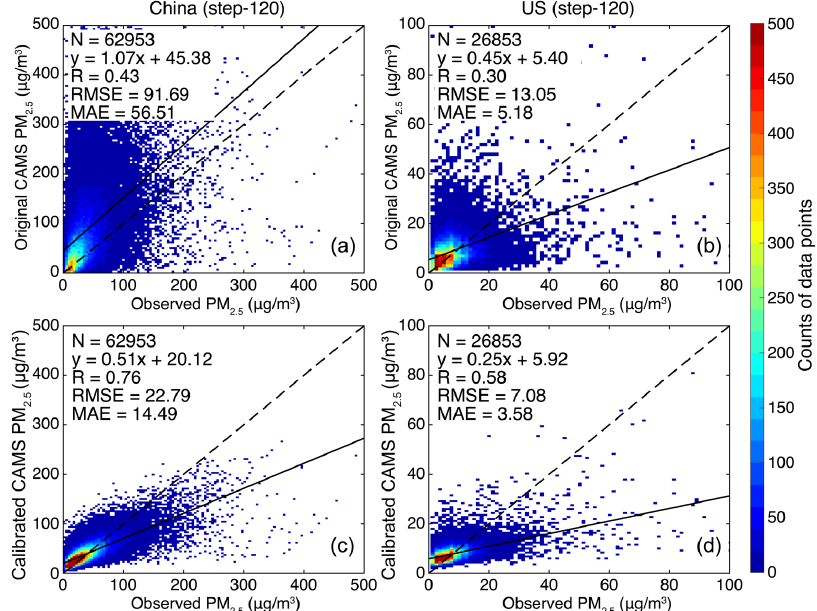
Figure 7. Comparison of the cross-validation accuracy between the original ( a , b ) and the calibrated ( c , d ) PM 2.5 forecasts with a forecasting time horizon of 120 h (step-120). Note the data values compared here were unseen data which were randomly selected and retained for the cross-validation purpose.